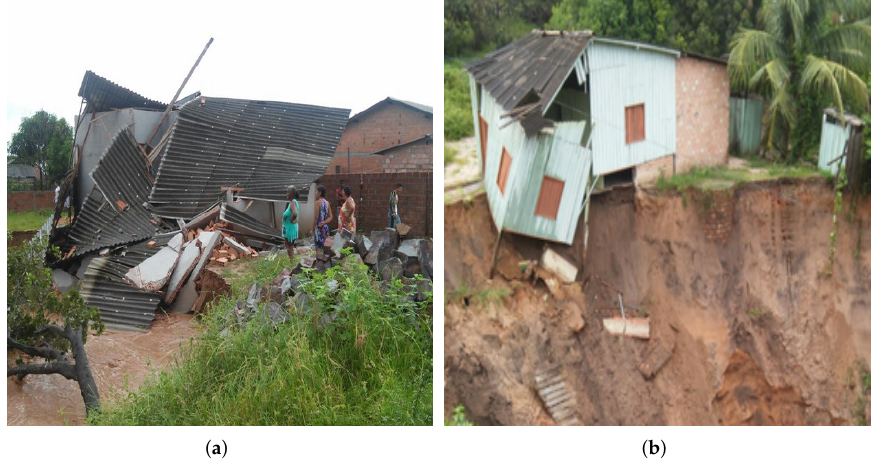
Figure 19. One of the municipalities affected by the extreme rain. ( a ) and ( b ) collapse of houses in mu- nicipality of Monte Alegre in Pará state. Photographs: Arney Barreto/G1 and Reprodução/TV